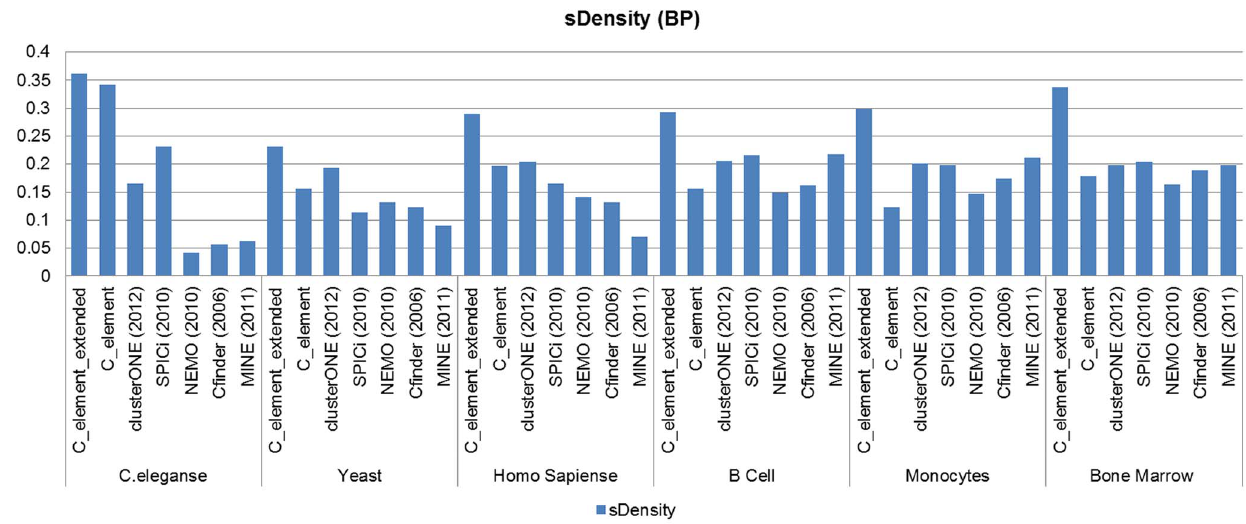
Figure 12. Semantic density measure analyses results on the six different networks and different algorithm considering GOBP derived functional